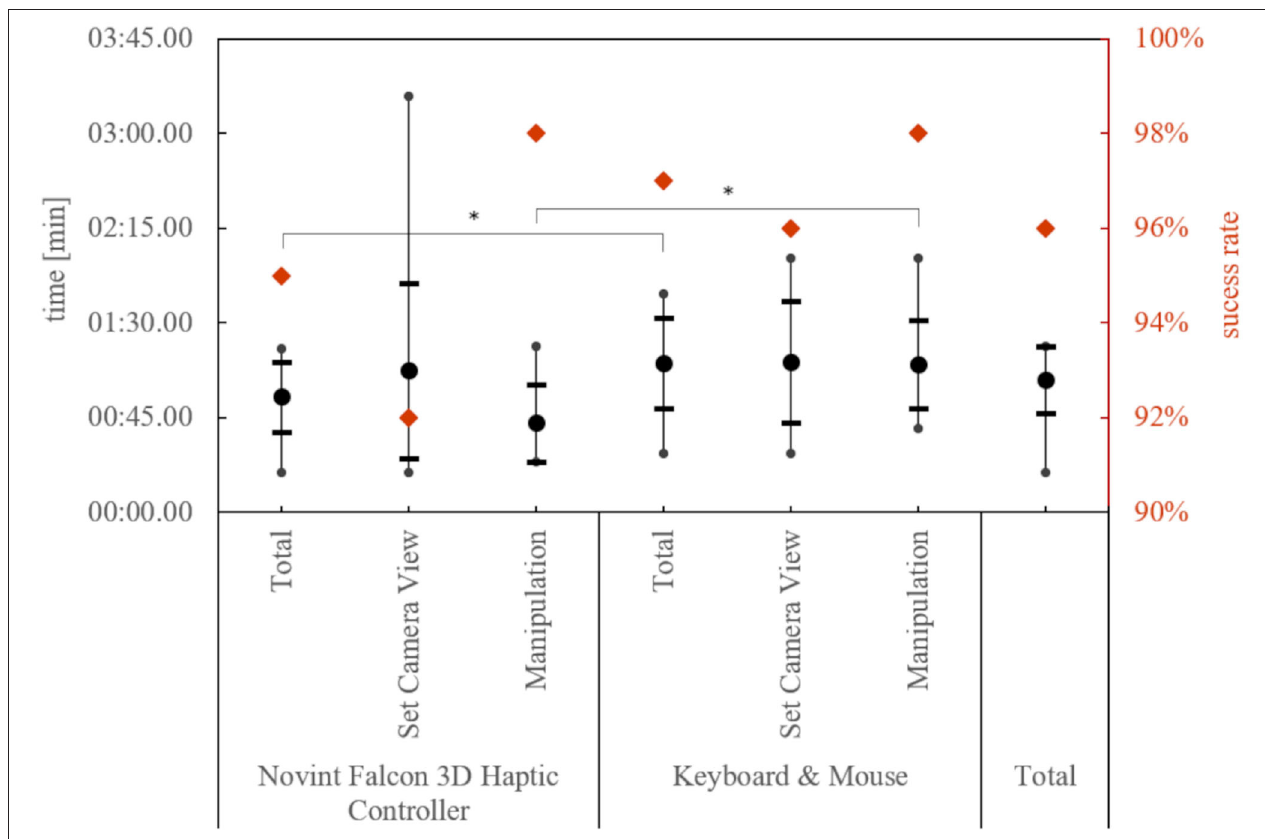
FIGURE 8 | Success rate and the mean of the minimum execution time of a subject by device and task. The thick dot represents the mean value, the horizontal lines the standard deviation, and the vertical lines the min/max limit. Significant differences in the execution times are marked with a